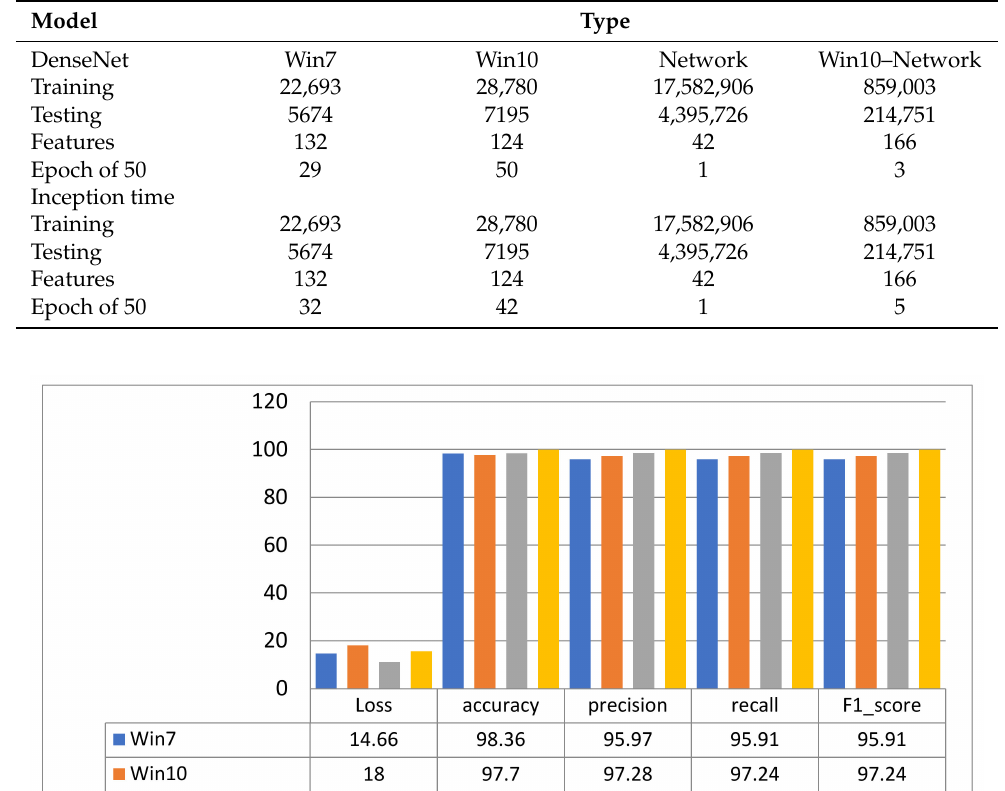
Table 6. The values of training and testing, the numbers of features used, and the values of the epochs for the Inception Time and DenseNet algorithms.